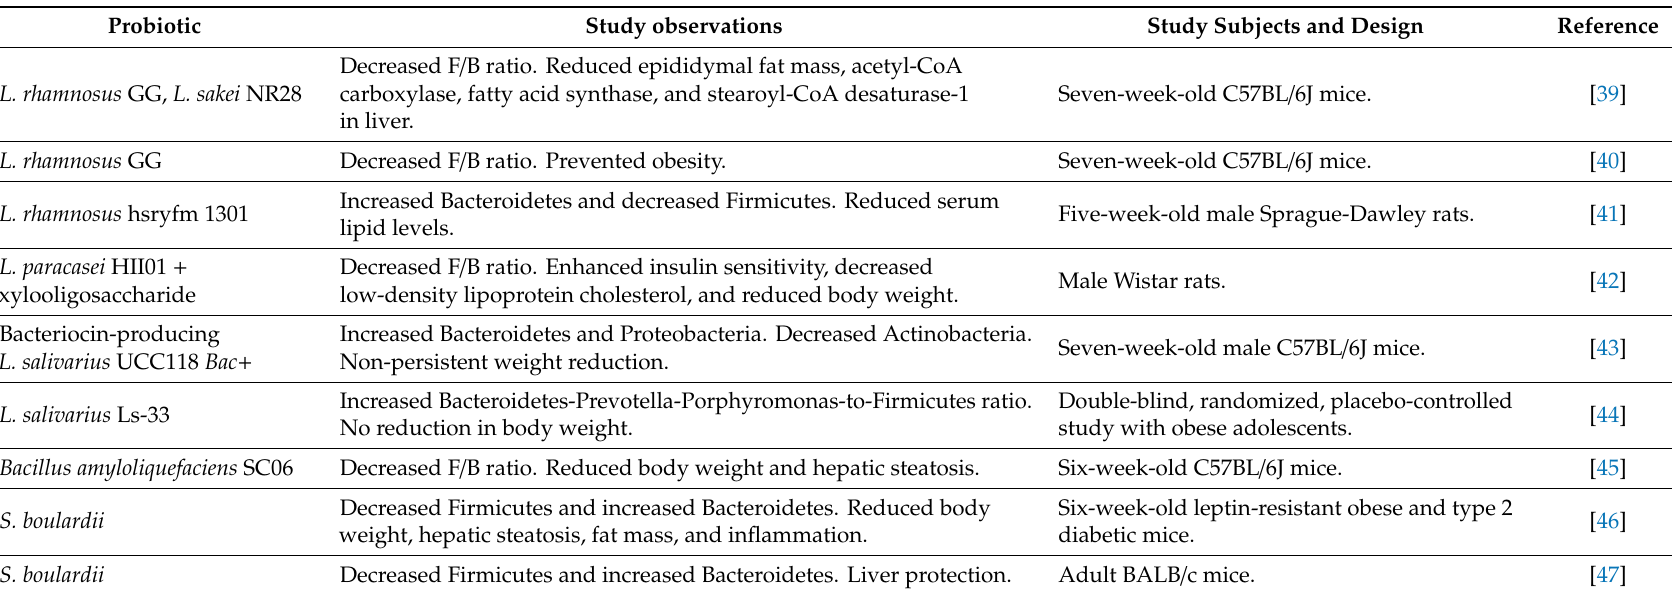
Table 1. Probiotics and their anti-obesity e ff ects via F / B ratio